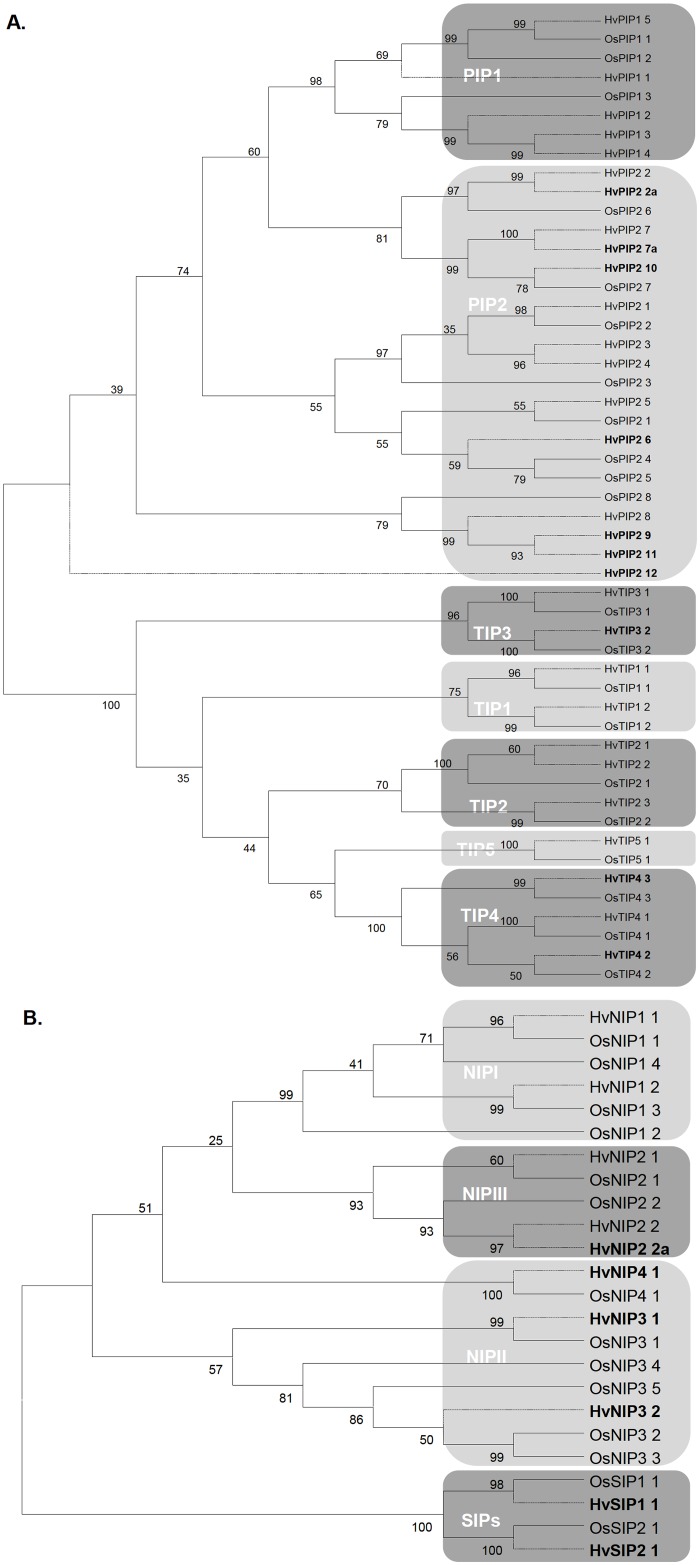
Phylogenetic trees of putative barley and rice aquaporin sequences.A. PIPs and TIPs; B. NIPs and SIPs. The phylogenetic trees were constructed in MEGA4.1 (maximum likelihood with bootstraps) based on the sequence alignments shown in S1 Fig. The different sub-families and groups are highlighted in different shades of grey. The AQPs annotated in this study are shown in bold. The branches corresponding to barley AQPs are shown as dashed lines while those for rice are solid lines.